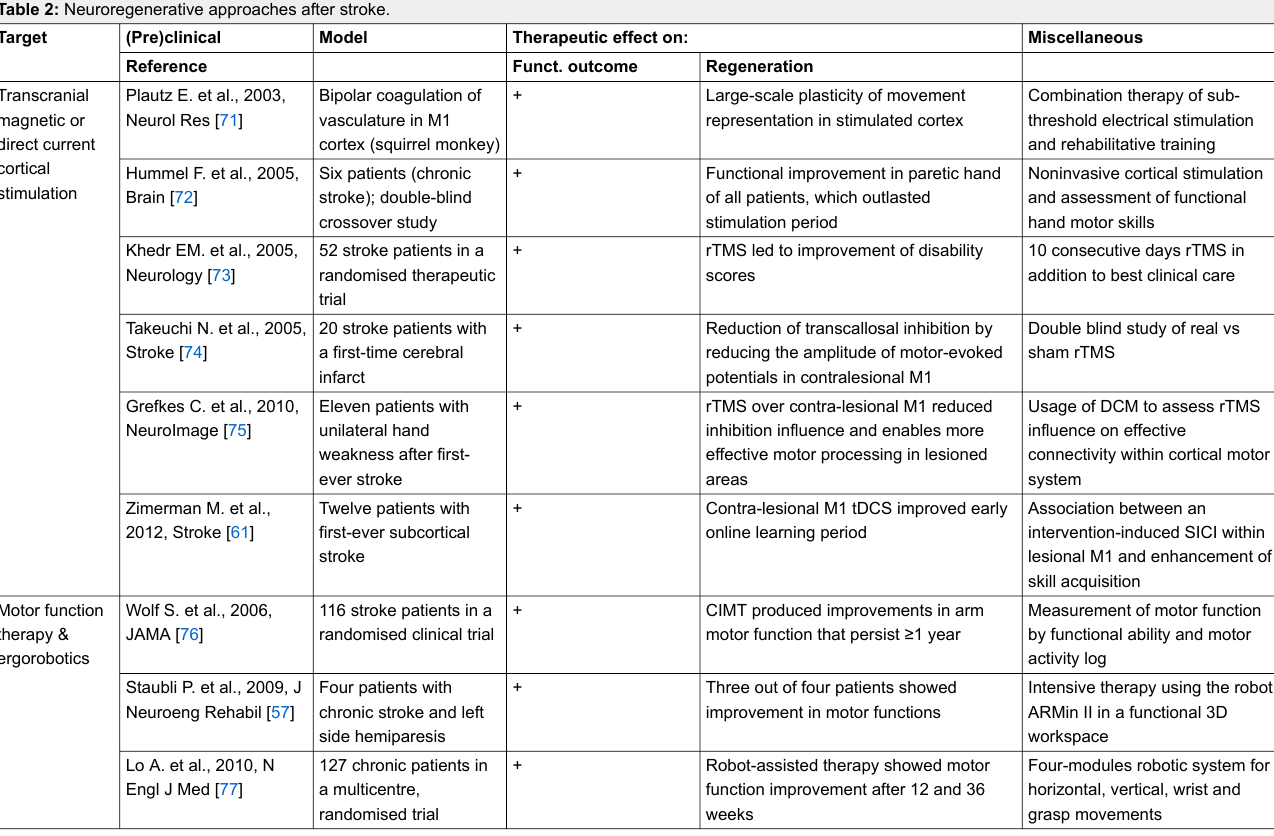
Table 2: Neuroregenerative approaches after stroke. (Pre)clinical